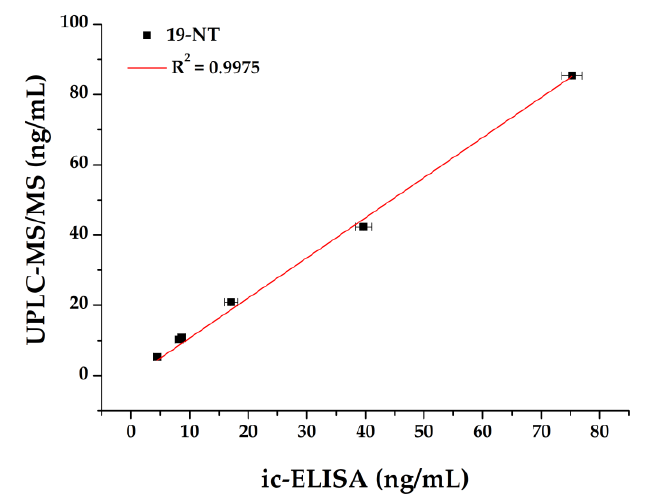
Figure 11. Correlations of analysis of samples spiked with 19-NT between ic-ELISA and UPLC– MS/MS.